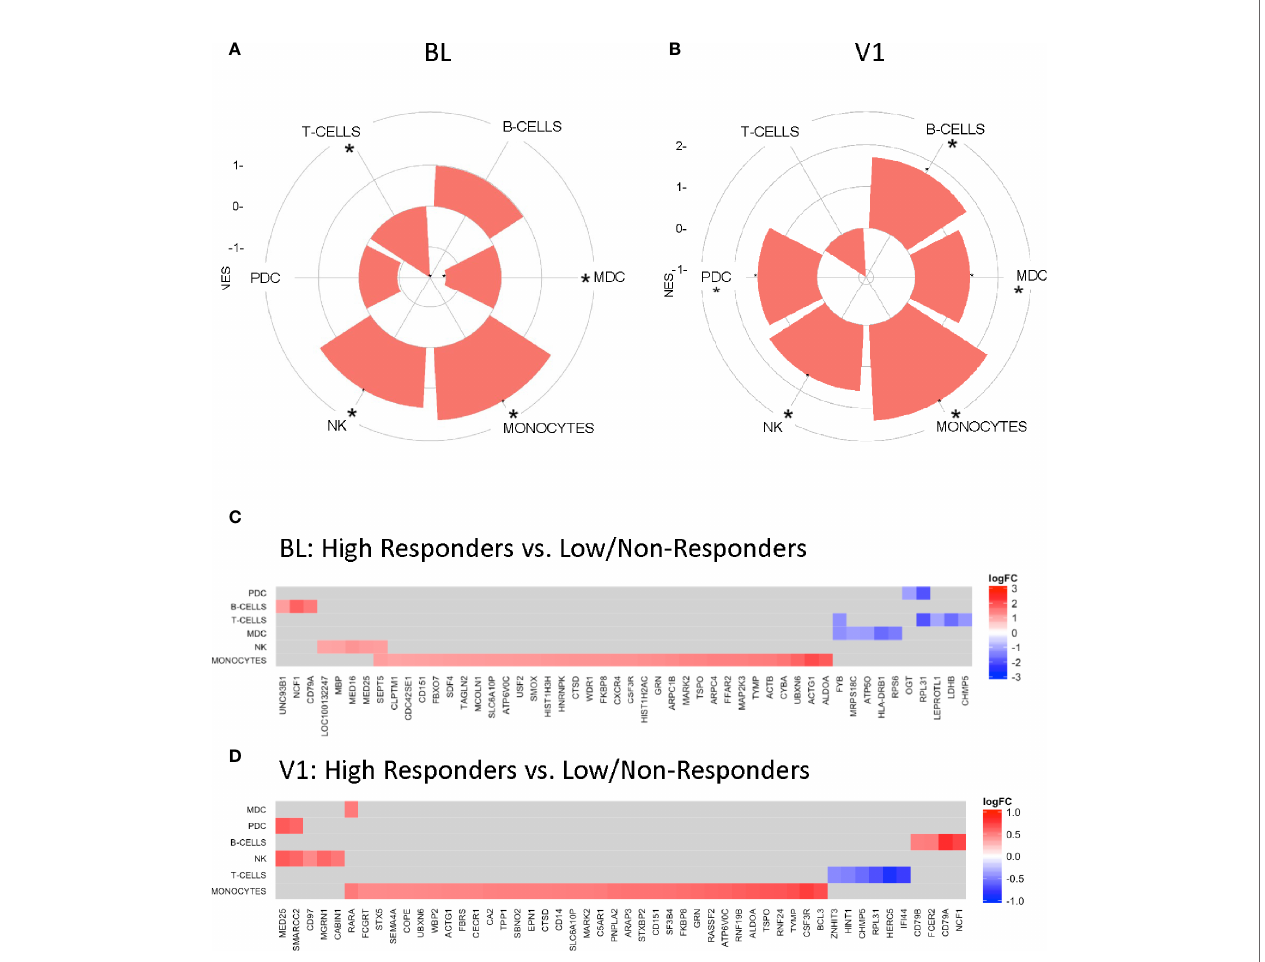
FIGURE 4 | Gene Set Enrichment using Nakaya.NatImmunology Cell Speci fi c Signatures. “ High ” responder and “ low ” responder clusters from regression analysis with baseline gene expression (A , C) and V1 gene expression (B , D) and fold change difference in pH1N1 titers (V1/BL) were subjected to gene set enrichment analysis using the Nakaya modules (21). (A , B) Radial plots illustrating selective enrichment in major PBMC cell types high responders compared to low/non- responders. (C , D) Genesets induced in a speci fi c subset are signi fi cantly enriched (adjusted p-value <0.05 denoted by *) among genes upregulated or downregulated with respect to the enrichment score – (NES) between